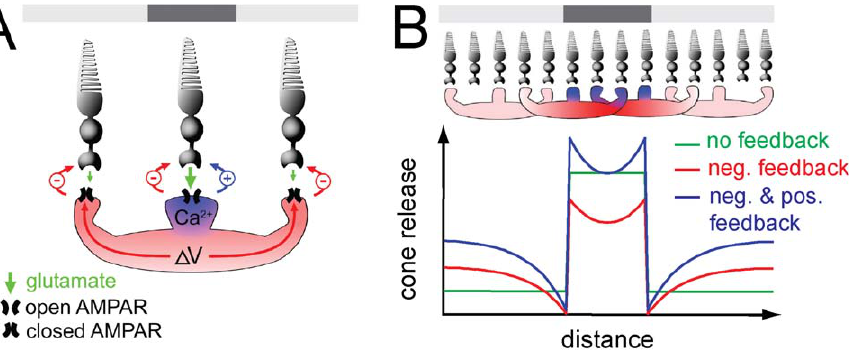
Figure 8. A conceptual model of positive feedback in the outer retina. (A) Diagram depicting the differential spread of positive and negative feedback within an HC. The top bar denotes the illumination pattern. A cone depolarized in darkness will release glutamate, activating AMPA receptors (APMARs), causing depolarization and Ca 2 + influx. The rise in Ca 2 + is restricted to the specific dendrite that contacts the cone, and the resulting positive feedback is localized to that cone. The depolarization spreads electrotonically through the HC, resulting in negative feedback from all of the dendrites. (B) Model simulations of the effect of feedback on synaptic release from a linear array of cones exposed to a dark spot on a non- saturating light background (see Methods). The positive feedback signal (blue) is localized to HC dendrites in contact with dark cones while the negative feedback signal (red) electrotonically spreads through the HCs. Traces show simulated cone release with no feedback (green), with negative feedback, (red), and with equally weighted negative and positive feedback (blue).